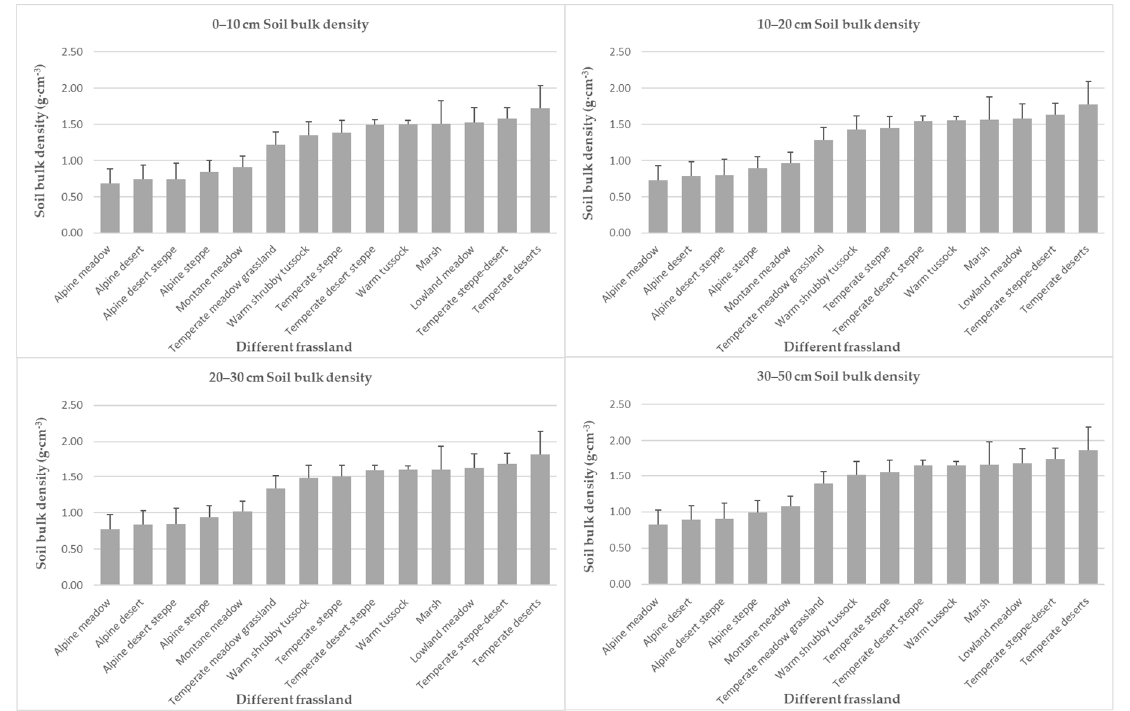
Figure 7. Stratified soil bulk density in di ff erent depths and grassland types. Mean +